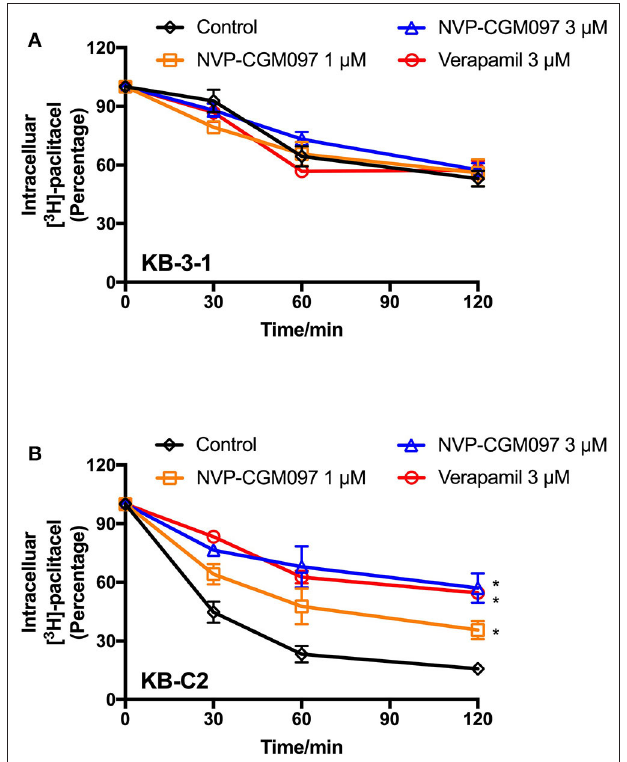
FIGURE 4 | NVP-CGM097 inhibited the efflux function of ABCB1 transporters. (A,B) The effects of NVP-CGM097 on efflux of [ 3 H]-paclitaxel in KB-3-1 and KB-C2 cells. Data are mean ± SD, representative of three independent experiments. * p < 0.05, compared with control group.